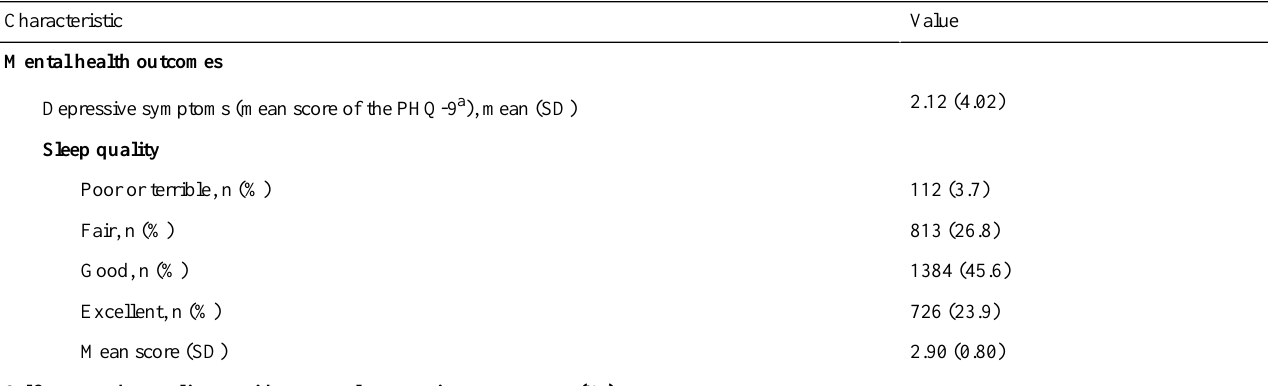
Table 3. Mental health and behavioral outcomes in the study sample